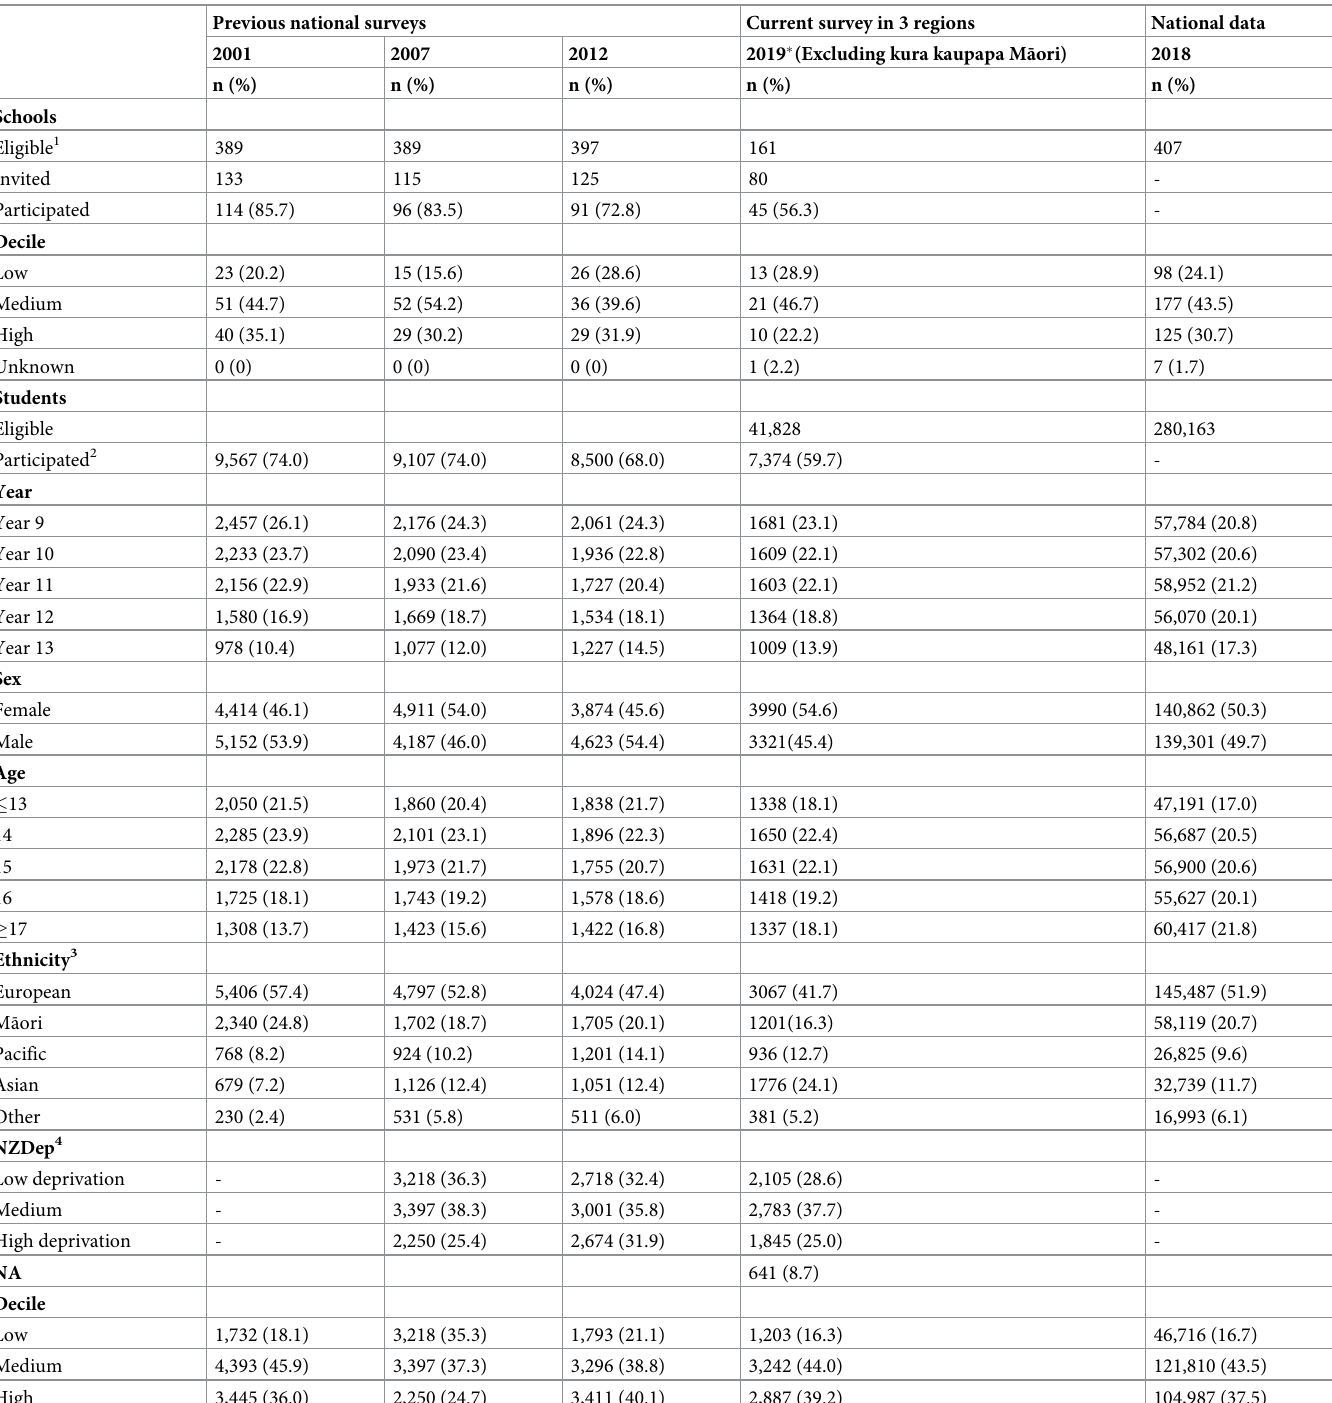
Table 2. Unweighted characteristics of participating mainstream schools and students from previous surveys and national school data prior to the